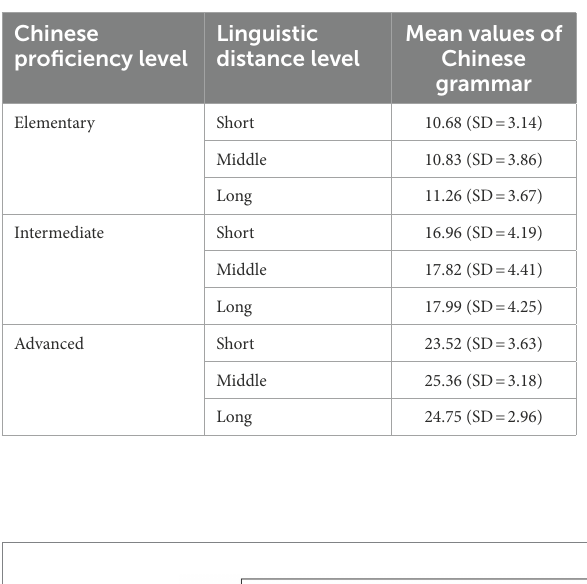
TABLE 4 Chinese grammar test score descriptive statistics.